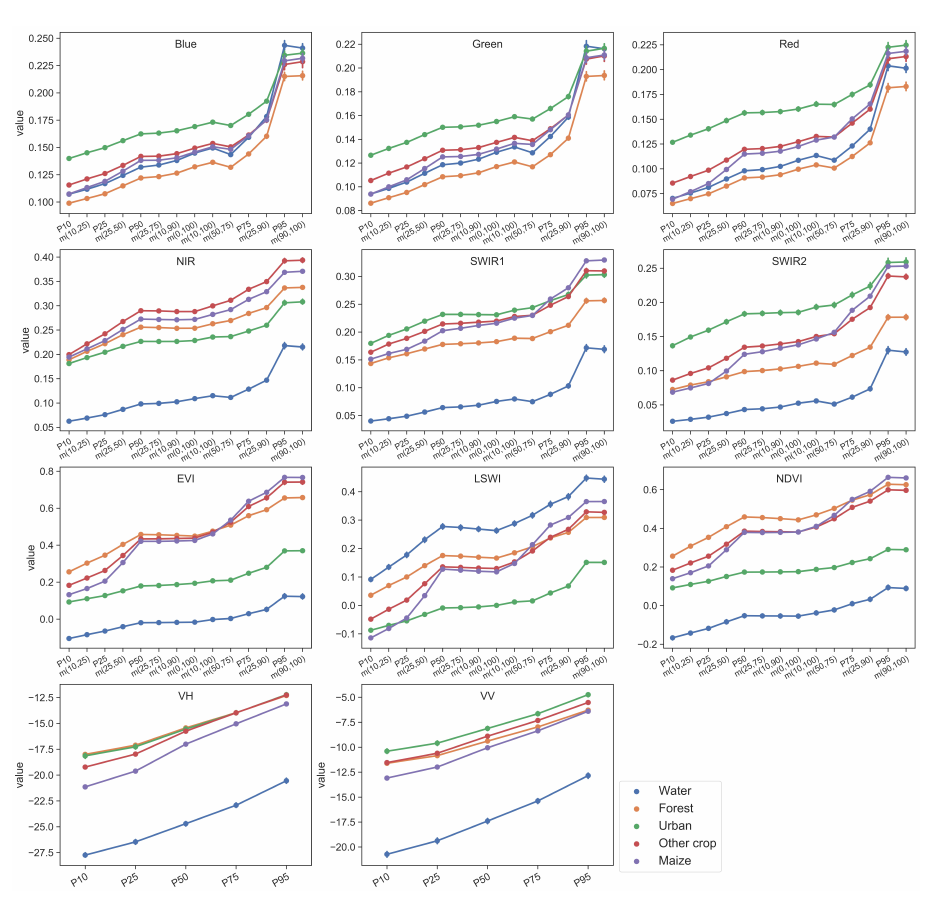
Figure 8. Quantiles and interval mean values of six optical bands, three VI bands, and two SAR bands for five classes. Each line is the average with 95% confidence intervals estimated for each class from all of the training